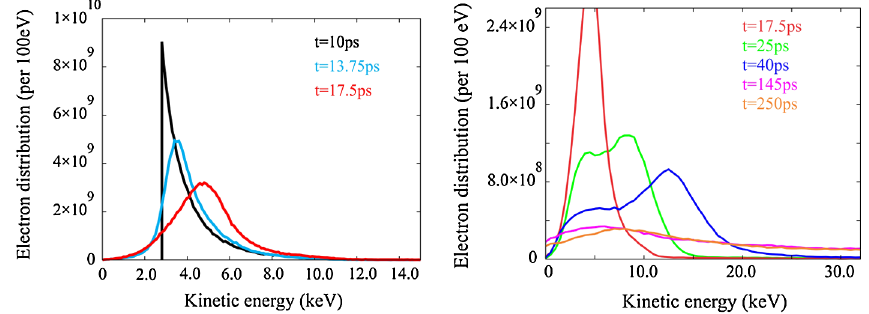
FIG. 11. Time evolution of the electron energy distribution. The right picture for t (cid:5) 17 : 5 ps has different